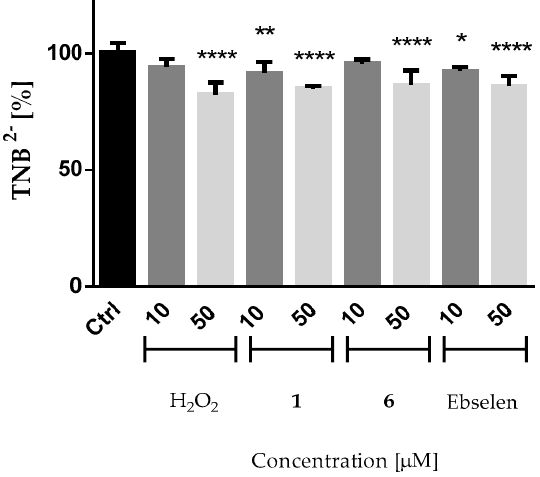
Figure 3. Estimation of levels of thiol residues of 100 µM N -acetyl- L -cysteine in the presence of different concentrations of compounds 1 , 6 , or ebselen by the DTNB assay. Hydrogen peroxide served as positive control in the study. The decrease in 2-nitro-5-thiobenzoate (TNB) indicates the ability of the compounds/H 2 O 2 to modify free sulfhydryl groups of various amino acids of the proteins. It should be noted that compounds have been added in substoichiometric amounts compared to N -acetyl- L -cysteine to account for possible thiol oxidation cascades. Statistical significance was assessed by one-way ANOVA (mean ± SD, n = 5 replicates) followed by Dunnett’s multiple comparisons test. * p ≤ 0.05, ** p ≤ 0.01 and **** p ≤ 0.0001 compared with the control.